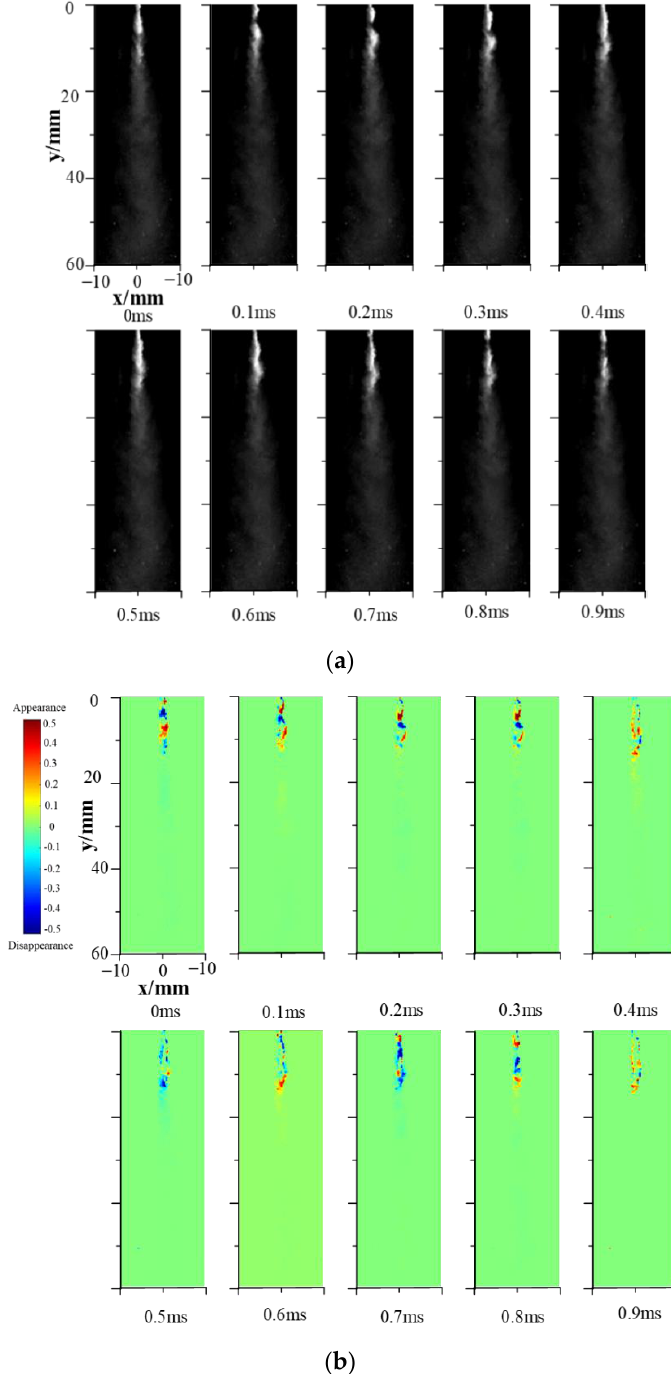
Figure 6. Dynamic change in the cavitation cloud in a single period under an inlet pressure of 10 MPa: ( a ) high-speed photography image of the cavitation cloud; ( b ) FDM diagram.